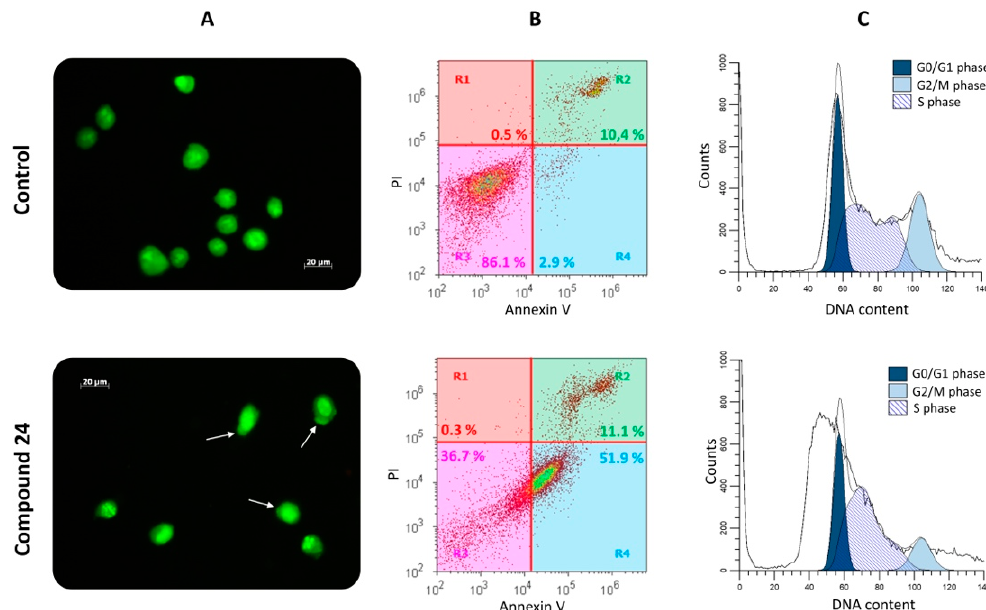
Figure 3. Extended cytotoxicity investigation after treatment of A375 cells with 24 (4.0 µM) for 24 h: ( A ) Fluorescence microscopic images (scale bar 20 µm), AO and PI were used; ( B ) Annexin V-FITC/PI assay. Examples of density plots determined by flow cytometry (Attune ® Cytometric Software v 1.2.5), R1: necrotic, R2: secondary necrotic/late stage apoptotic, R3: vital, R4: apoptotic; ( C ) Representative examples for cell cycle evaluation via ModFit LT 5.0.